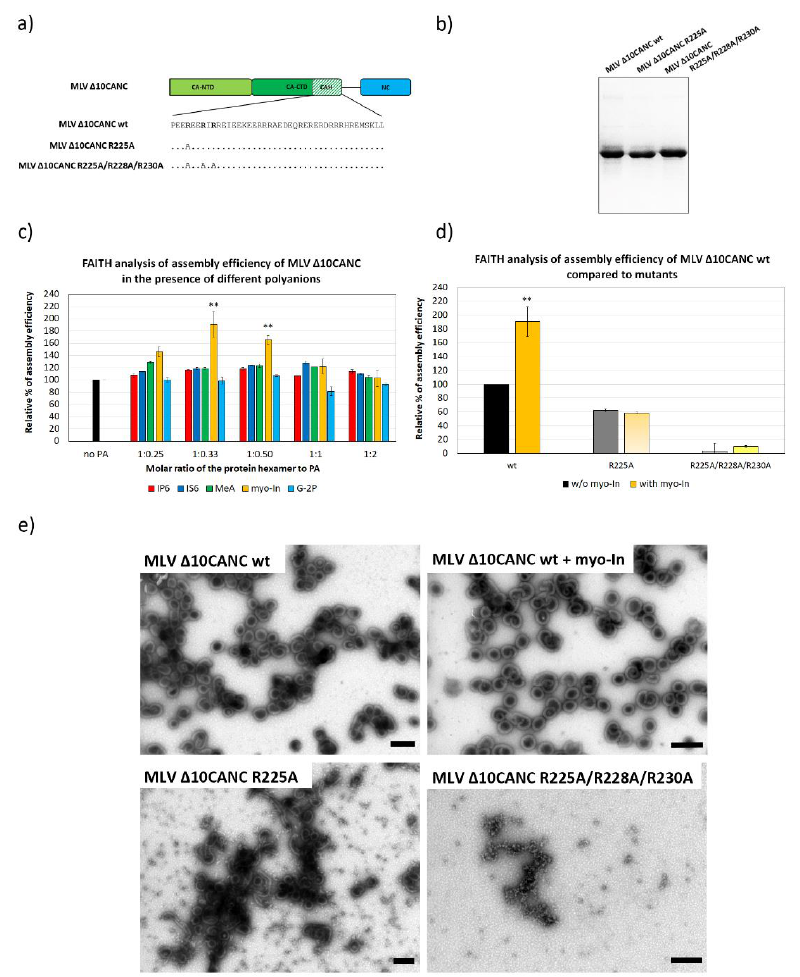
Figure 3. The efficiency of MLV ∆10CANCwild type (wt) and mutant proteins’ assembly in the presence of selected polyanions. ( a ) Schematic representation and amino acid sequence of MLV ∆10CANCwt and R225A and R225A/R228A/R230A mutants. ( b ) Coomassie blue-stained SDS-PAGE gel, documenting the purity of MLV ∆CANC wt and R225A and R225A/R228A/R230A mutants. ( c ) Percentage of assembly efficiency of MLV ∆ 10CANC wt protein in the presence of different concentrations of IP6 (red), IS6 (royal blue), MeA (green), myo-In (yellow) and G-2P (azure blue) at indicated ratios of protein hexamer to polyanions. p -values were assessed by ANOVA using the Tukey–Kramer test (**, p < 0.01). ( d ) Percentage of assembly efficiency of MLV ∆10CANC wt (black column), R225A (dark grey column) and R225A/R228A/R230A (light grey column) compared to the proteins assembled in the presence of 1.2 µM myo-In (yellow). p -values were assessed by ANOVA using the Tukey–Kramer test (** p < 0.01). ( e ) TEM analysis of nega- tively stained MLV ∆10CANC wt protein assembled in the absence or presence of myo-In at a final concentration of 1.2 µM (ratio of the protein hexamer to myo-In was 1:0.5) and both the R225A and R225A/R228A/R230A mutants in the absence of myo-In. Bars represent 200 nm.